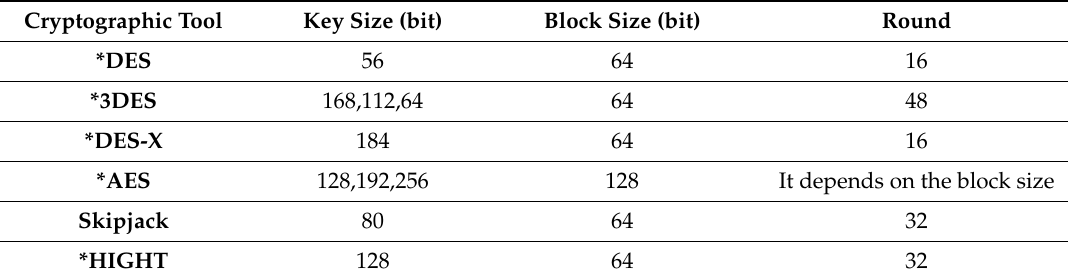
Table 1. Comparison of investigations with the contribution in this paper. Cryptographic